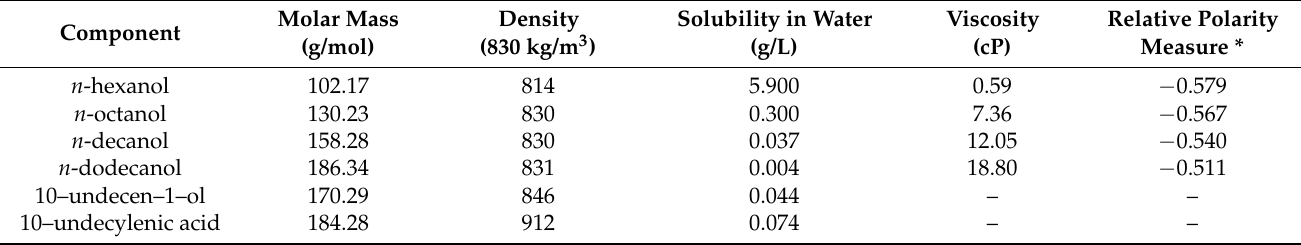
Table 1. The characteristics of the liquid membranes